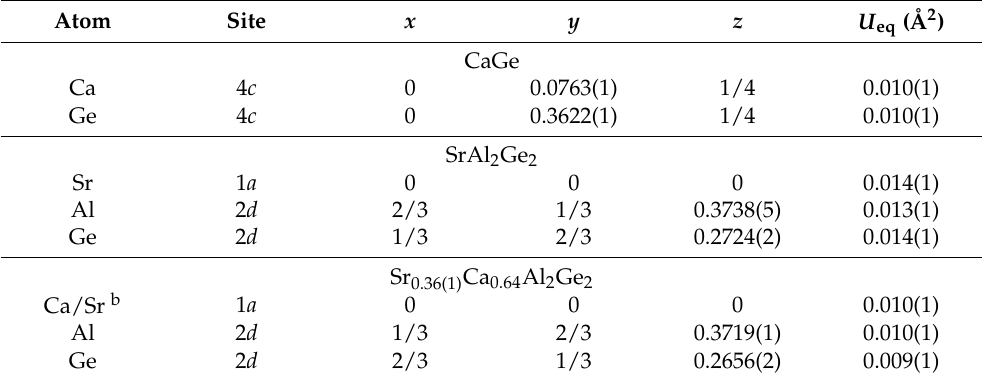
Table 2. Atomic coordinates of the atoms and their equivalent isotropic displacement parameters U eq a for CaGe, SrAl 2 Ge 2 , and Sr x Ca 1 − x Al 2 Ge 2 ( x ≈